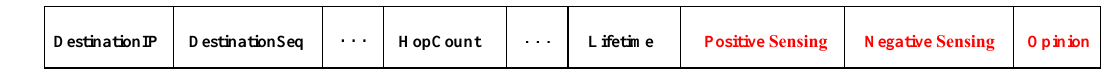
Figure 4. Extended routing table for AODV routing protocol having trust fields i.e., positive and negative